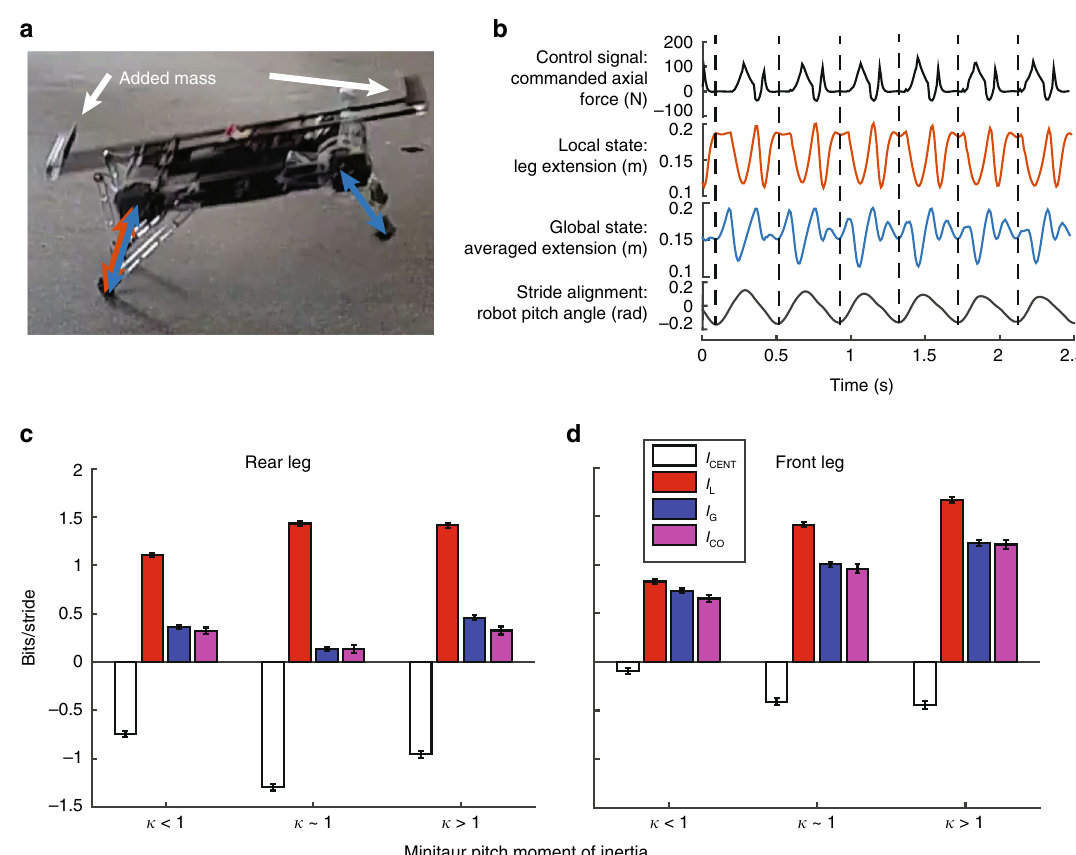
Fig. 5 Centralization of the bounding Minitaur robot. a Image of Minitaur showing the adjustable weight system. The arrows indicate leg extensions used for the local and global states. b The commanded torque at the hip to drive the extension of a single leg was selected as the control signal. The local state was the measured extension of that leg. The global state was the average of all leg extension trajectories. Strides were aligned by the pitch angle of the robot. c I CENT and I CO of the three different moment of inertia conditions. The estimated axial force to a rear leg was used as the control variable. d Estimated axial force to a front leg was used as a control